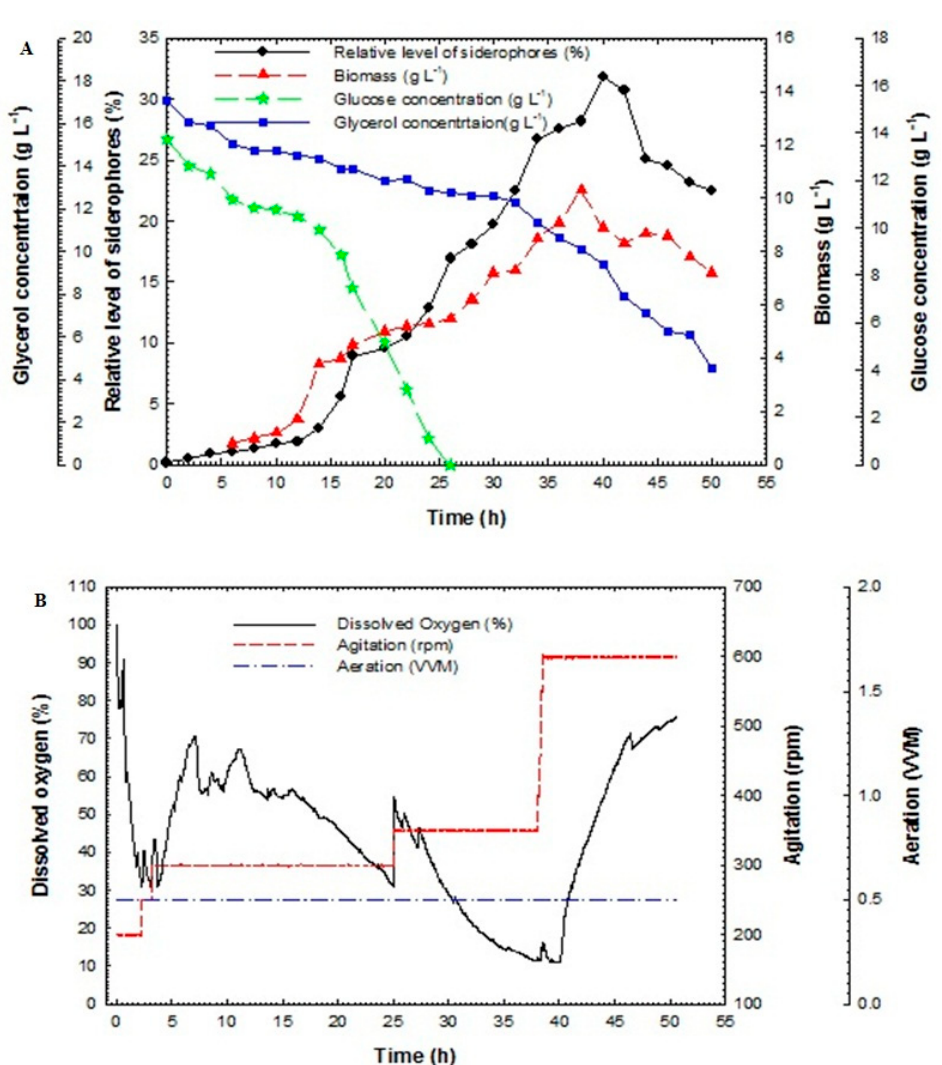
Figure 3. ( A ) Relative level of siderophores, biomass, glucose concentration and glycerol concentration as a function of time for batch fermentation culture broth of Pseudomonas aeruginosa F2 and ( B ) dissolved oxygen, agitation and aeration as a function of time during batch fermentation of Pseudomonas aeruginosa F2.